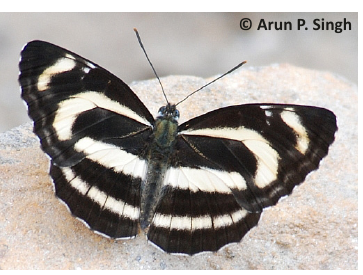
Image 10. Pale Hockeystick Sailer Neptis manasa manasa